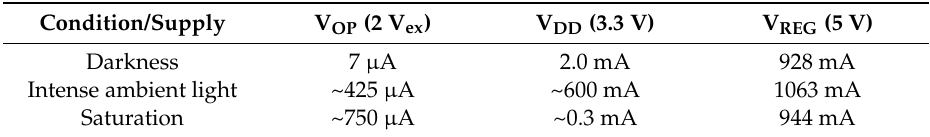
Table 1. Current consumption for a LinoSPAD camera; the excess bias voltage was set to 2 V and the quenching voltage to 1 V. V OP supplies the SPADs, V DD the sensor I/O, and V REG the power regulators on the FPGA